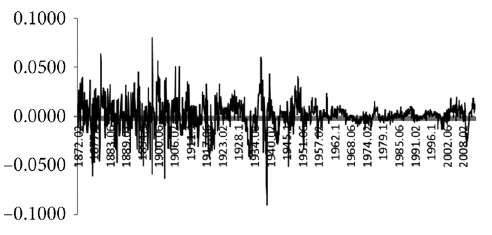
Figure 5. Growth in real